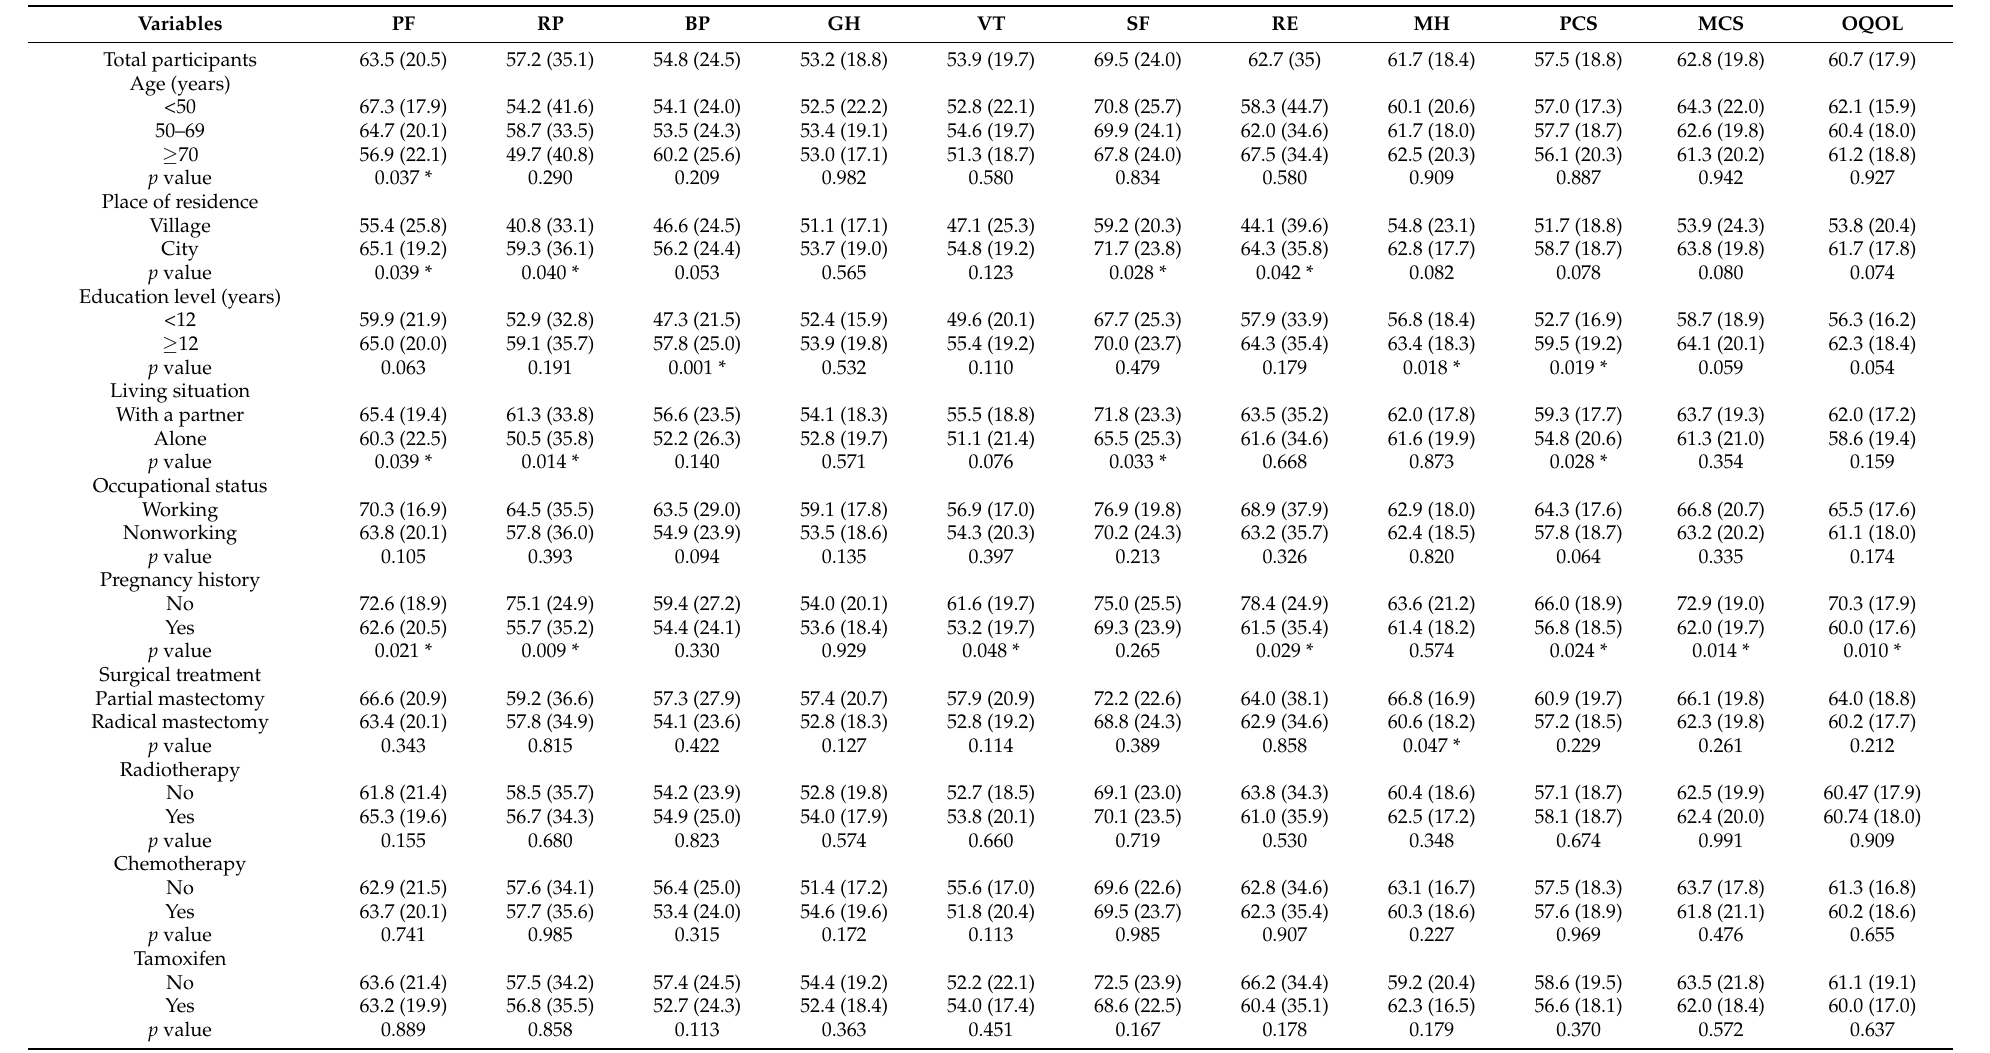
Table 3. SF-36 scores by sociodemographic, medical, and general health characteristics in long-term breast cancer survivors ( n = 250).